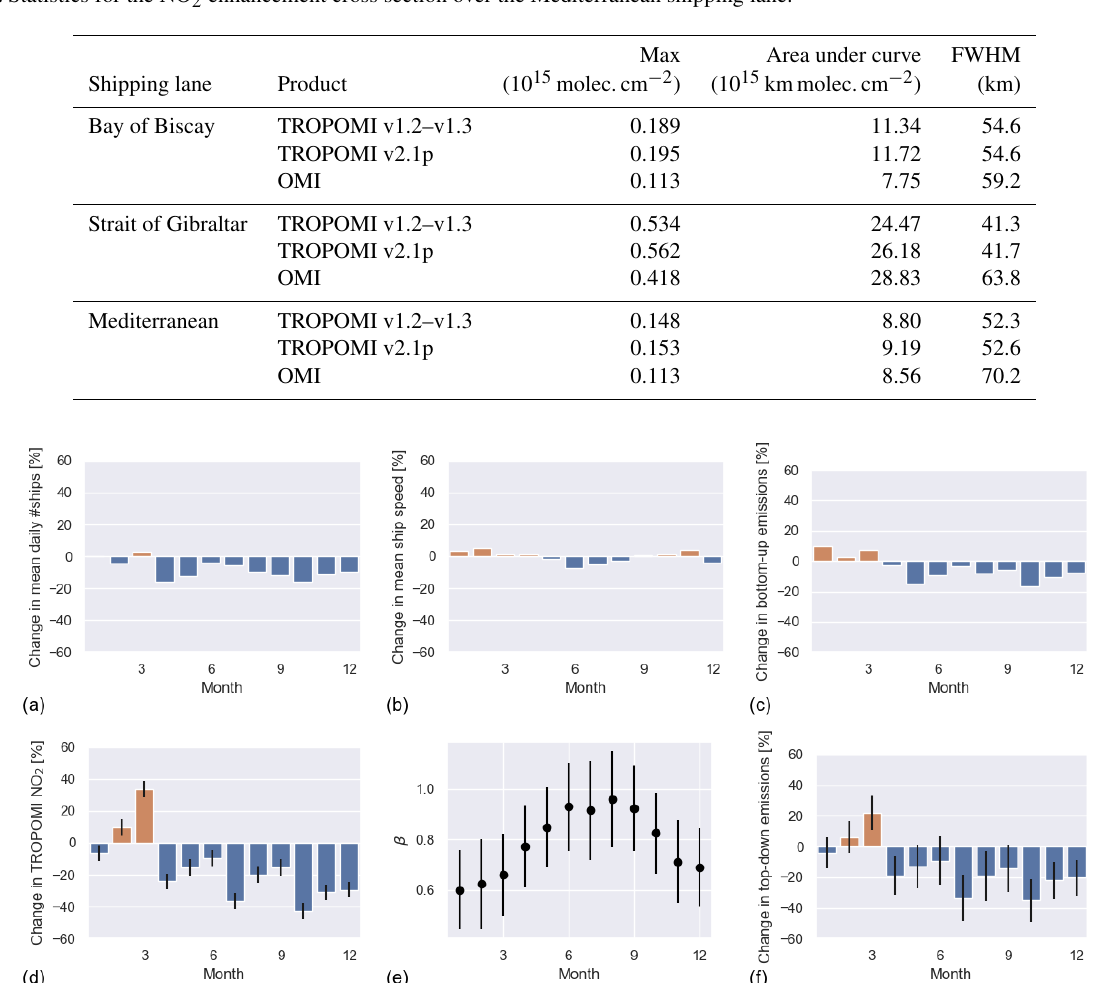
Figure 10. (a) Relative change in monthly mean of daily number of ships passing the Strait of Gibraltar between 2019 and 2020 inferred from AIS data. (b) Same but with average ship speed. (c) Relative change in emission proxy ( v 3 · L 2 ). (d) Relative change in TROPOMI shipping NO 2 . (e) Monthly β values from Vinken et al. (2014b) with month-to-month variability imposed by monthly values from Verstraeten et al. (2015). Uncertainty intervals represent the temporal and spatial variability in β (see discussion in the text). (f) Relative change in top-down emissions from shipping. Error bars represent the propagated uncertainties in TROPOMI shipping NO 2 , β , and differences in meteorological conditions between 2019 and 2020 (see discussion in the